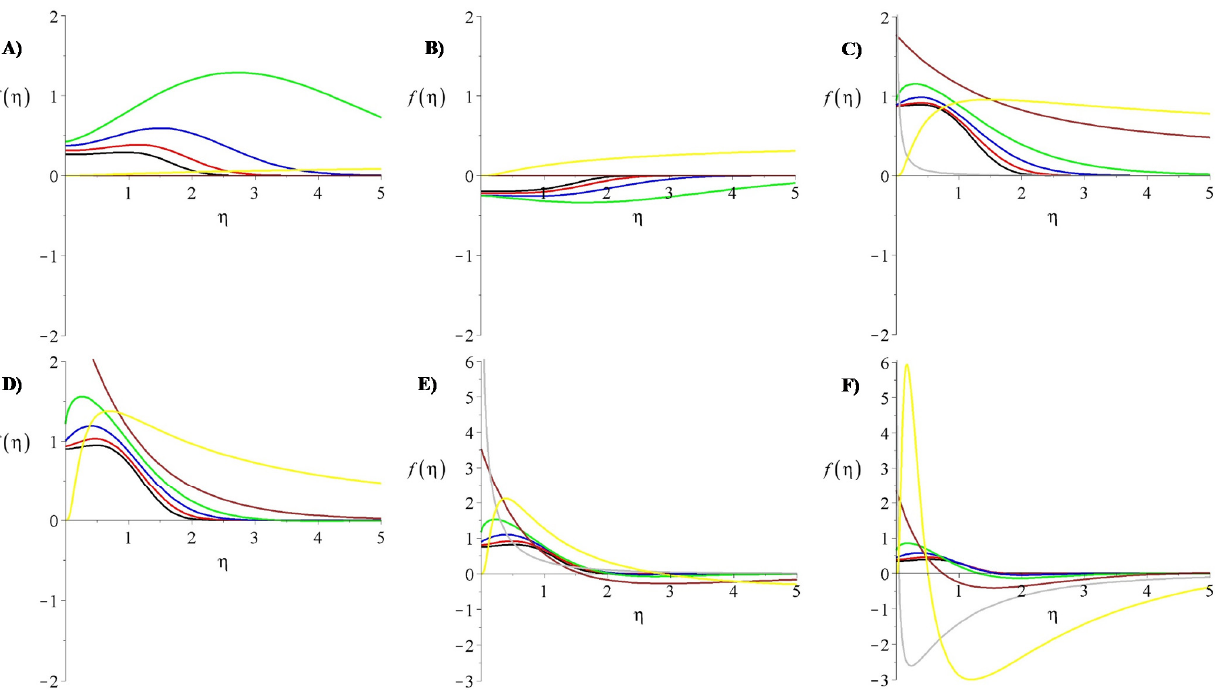
Figure 1. Shape functions of Equation (3) in the case of generalized space-dependent diffusion coefficients for various values of α with different m exponents of the diffusion parameter: ( A ) α = − 2, ( B ) α = − 1, ( C ) α = 1 , ( D ) α = 1, ( E ) α = 3 , ( F ) α = 5 . The real part of the solutions is presented for D = 1, c 1 = 0, c 2 = 1. The black, red, blue, green, brown, grey, and yellow lines are for m = − 1 , − 1 , 0, 1 , 1 , 3 , and 5 , respectively.